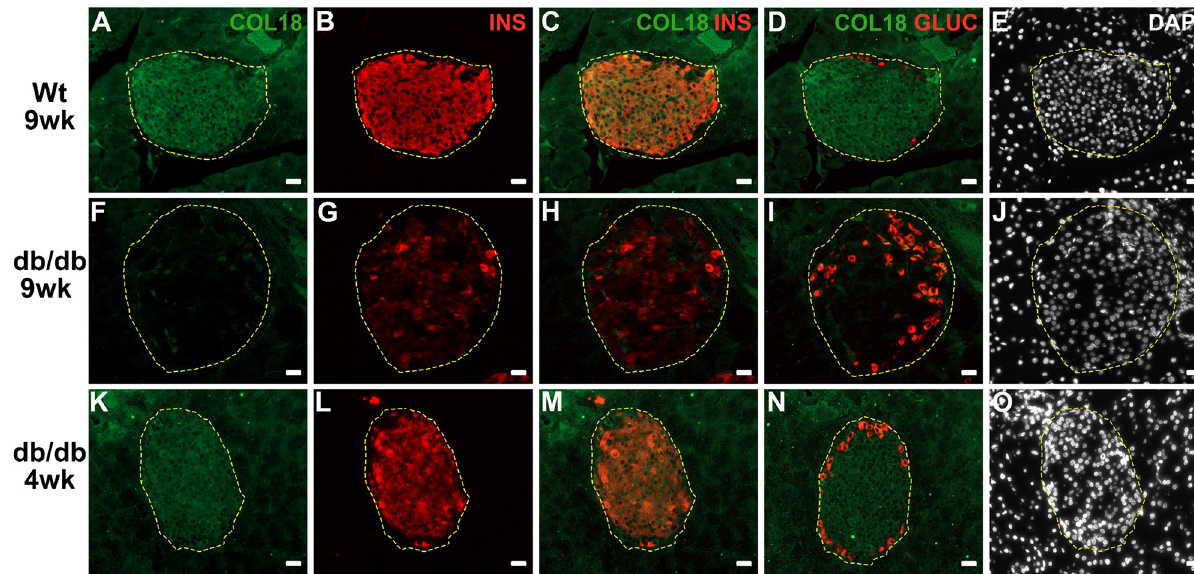
Fig 2. Intra-islet COL18 core protein colocalizes with insulin not glucagon staining in wt pancreas and is progressively lost in db/db pancreas. Immunofluorescence staining of ( A, F, K ,) COL18, ( B, G, L ) insulin (INS), ( C, H, M ) insulin and COL18 merged, ( D, I, N ) glucagon (GLUC) and COL18 merged in 9 wk wt ( A-D ), 9 wk db/db ( F-I ) and 4 wk db/db ( K-N ) pancreas. ( E, J, O ) Nuclei were stained with DAPI. Scale bar = 20 μ m.